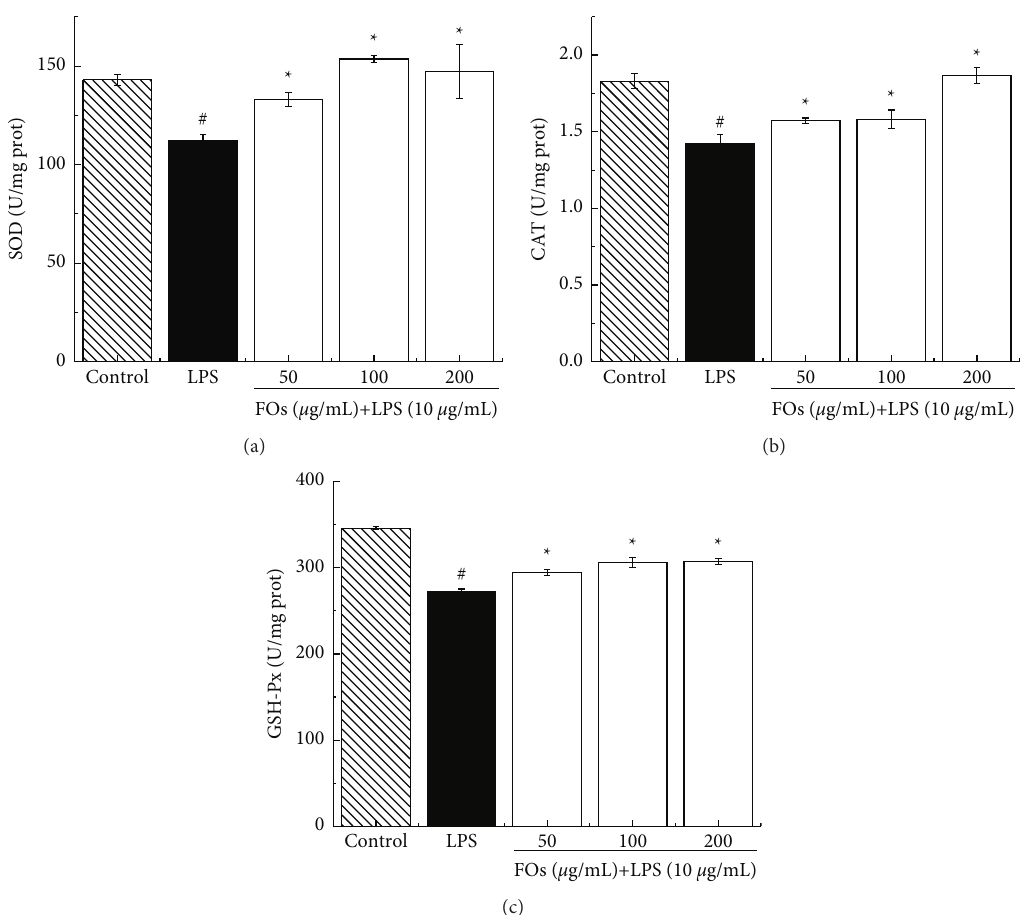
Figure 3: The effects of various concentrations of FOs-FWB on the activity of SOD (a), CAT (b), and GSH-Px (c) of LPS-stimulated IPEC-J2 cells. The data are expressed as the mean ± SE ( n � 3). # Indicates significant differences from control. ∗ Indicates significant differences from LPS. FOs-FWB: feruloyl oligosaccharides from fermented wheat